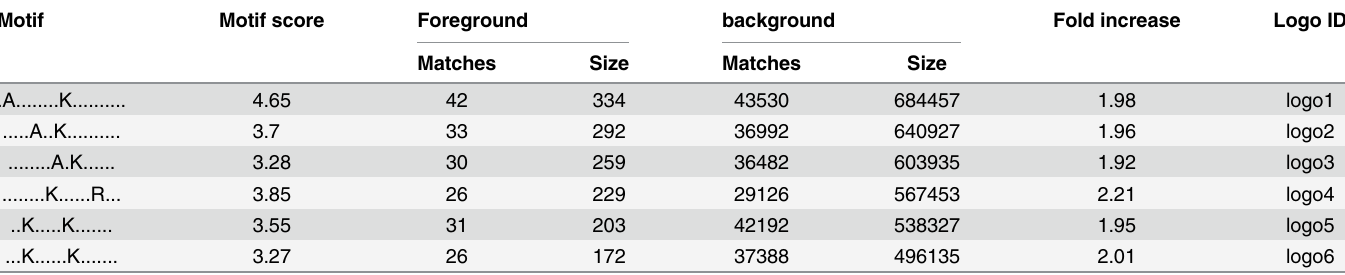
Table 4. Motif Analysis for Identified the Succinylated Lysine Peptides in